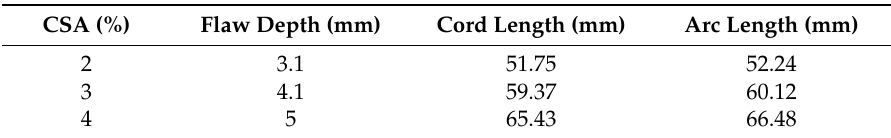
Figure 16. Schematic of the saw-cut defects introduced in the wall of the pipe (not to scale). Table 2. Defect specifications.